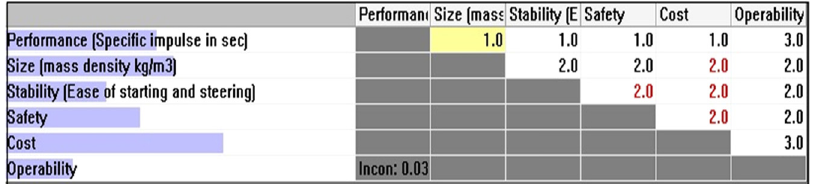
Figure 4: Judgment matrix of the main criteria with respect to the goal ( Red values mean reciprocals, i.e., the value of 2 in red color means ½. ) .